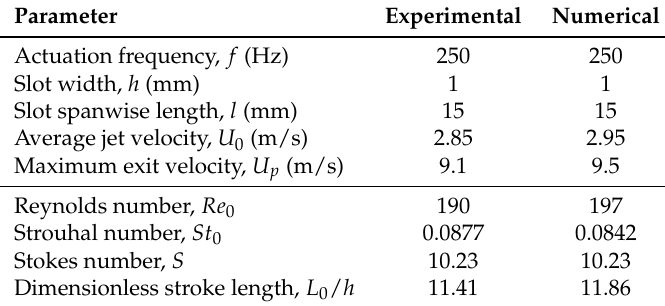
Table 1. Main dimensional and non-dimensional parameters for the analyzed